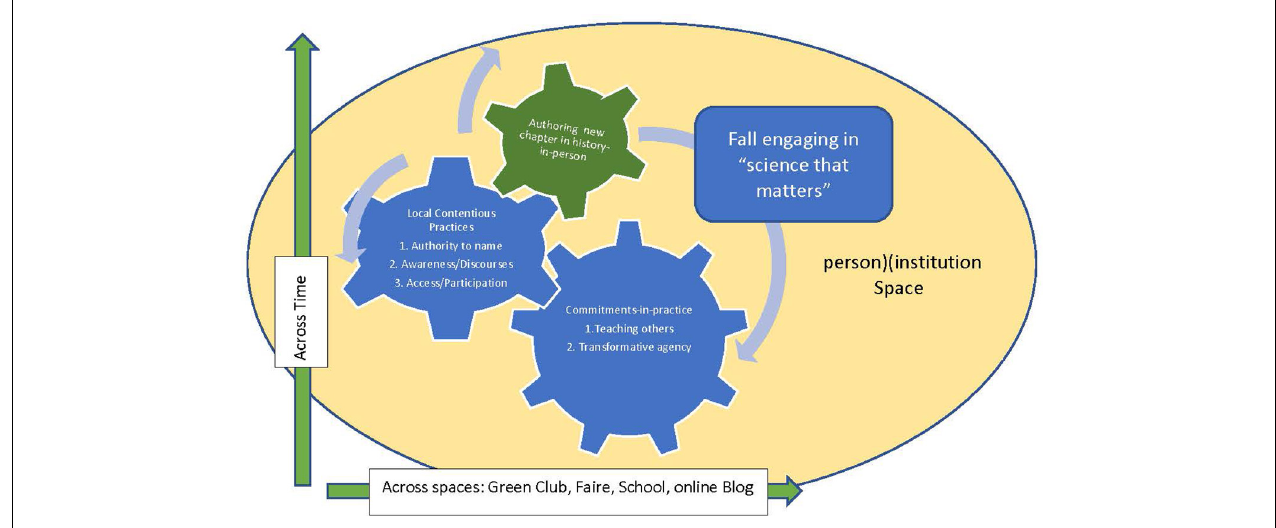
FIGURE 1 | Relationality between Fall’s commitments-in-practice, local contentious practices in the process of authoring a new chapter in her STEM